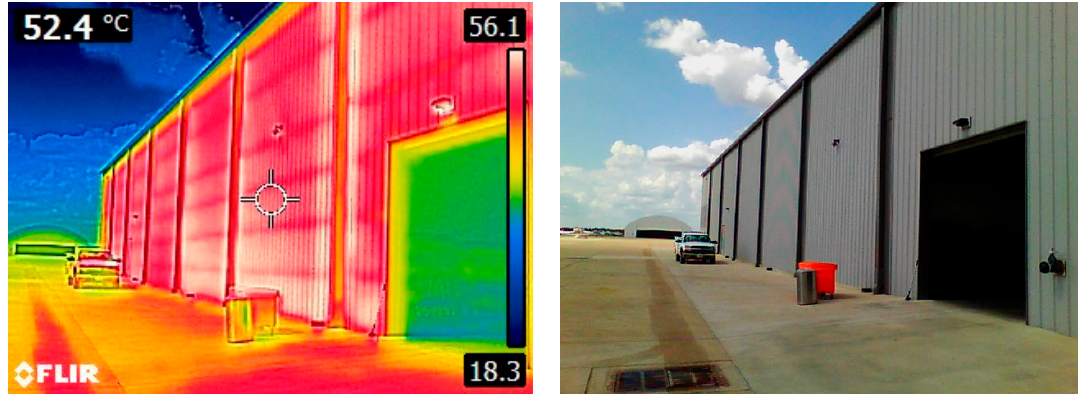
Figure 3. Current ramp setting for daily operations with surface thermal properties. COMFA Energy Budget = +275 W/m 2 (person would prefer to be much cooler and is in danger of heat stress).